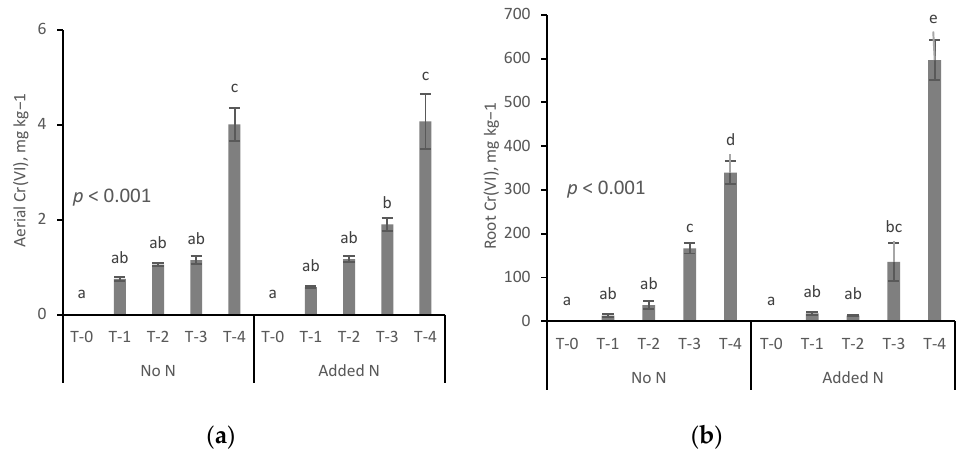
Figure 1. Cr(VI) concentration in plant tissues: ( a ) Aerial tissue Cr(VI) concentrations (mg Cr(VI) kg −1 dry matter); ( b ) Root tissue Cr(VI) concentrations (mg Cr(VI) kg −1 dry matter). Different letters denote statistically significant differences at p < 0.05 . Error bars represent standard error (T-1 = 25, T-2 = 50, T-3 = 100, T-4 = 150 mg Cr(VI) kg −1 soil).